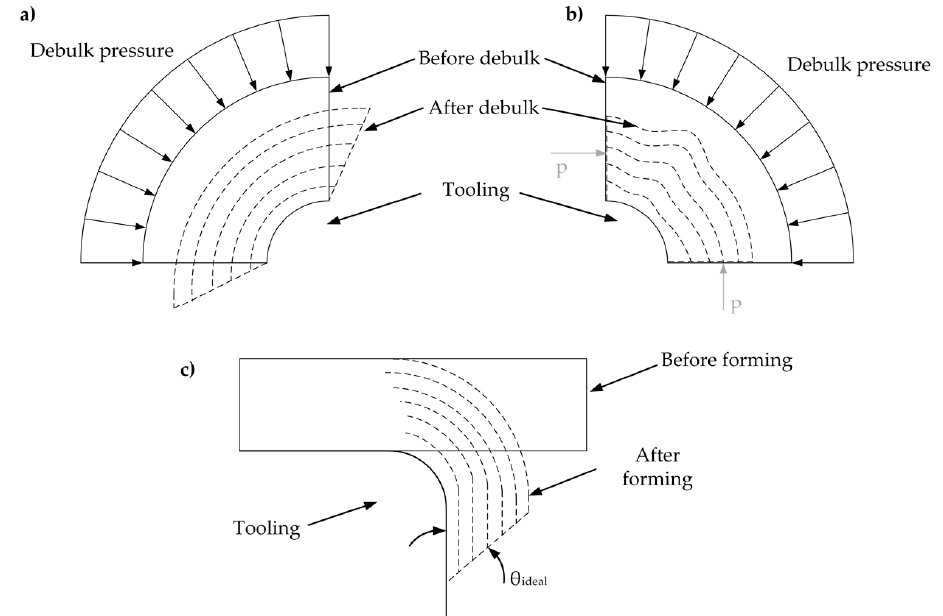
Figure 11. ( a ) Representation of the book-end effect, created when a laminate is consolidated unconstrained over a corner radius and slippage occurs; ( b ) constrained consolidation due to high shear resistance leading to fiber waviness; ( c ) book-end resulting from forming process illustrating the termination angle θ .